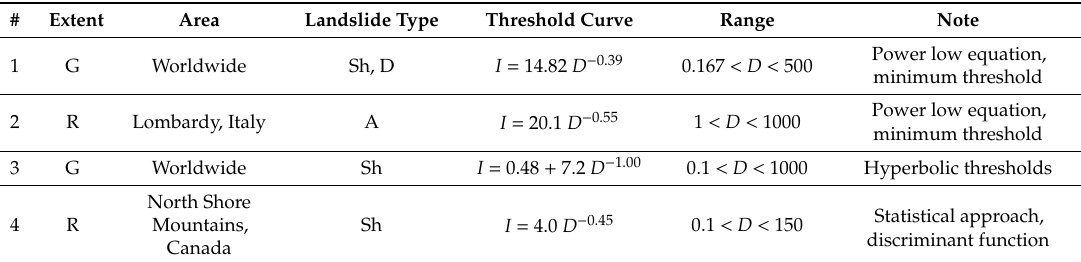
Table 9. ID rainfall thresholds for the possible initiation of shallow landslides in similar mountain and climate regions in Italy and worldwide. Geographical extent: G, global; R, regional; L, local; C, single catchment. Area: where the threshold has been defined. Landslide type: A, all; D,